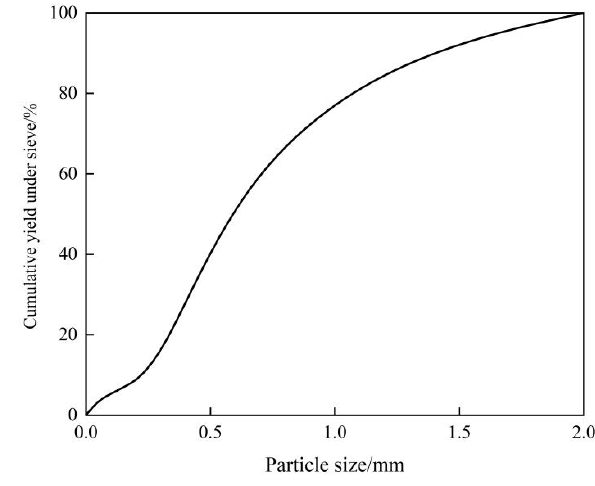
Figure 1. Particle size distribution of the test samples.